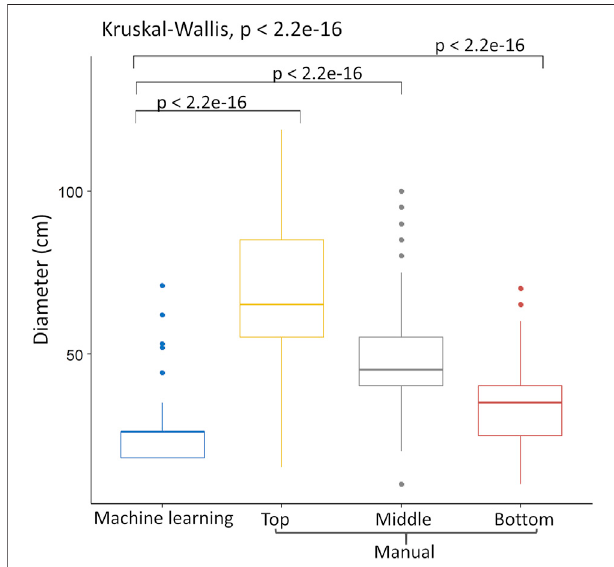
FIGURE 7 | Kruskal – Wallis test of manually measured diameter from threeheightsof Leptospermum plant(top,middle,andbottom)vs.automated canopy diameter estimation using UAV imagery and ML.